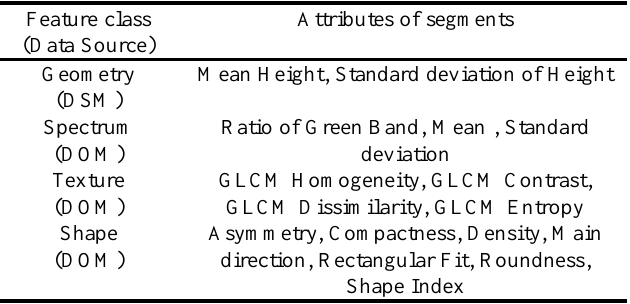
Table 1. Features used in the DSM and DOM segments